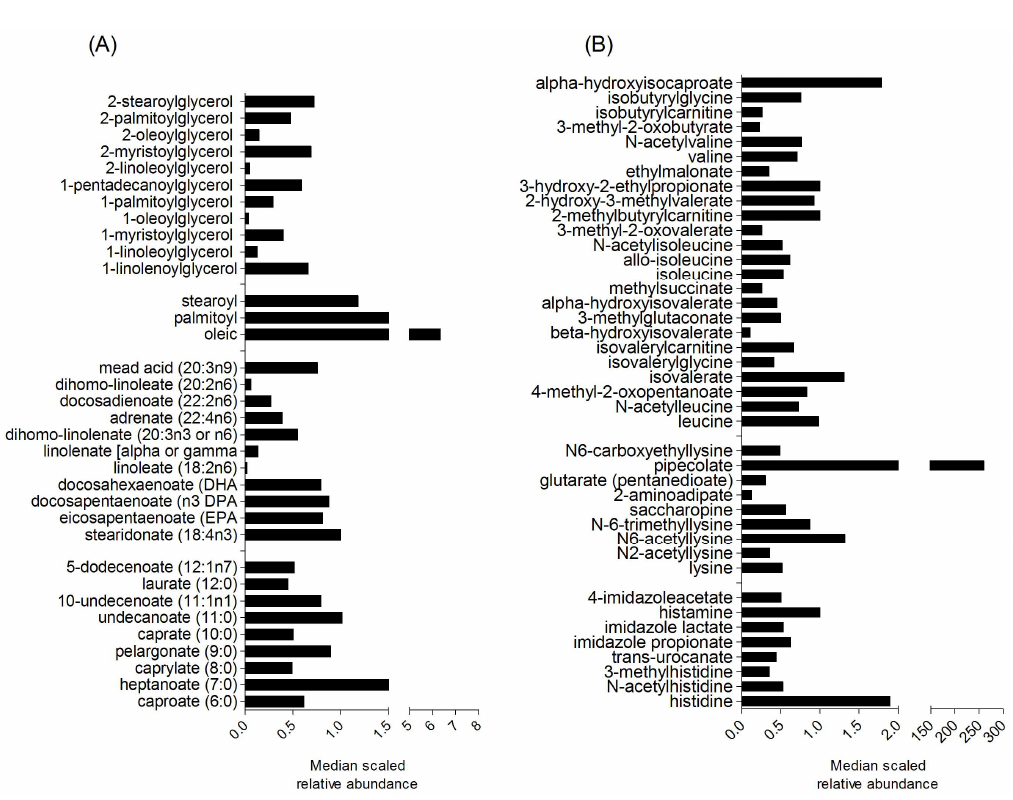
Figure 1. Median scaled relative abundances of selected navy bean metabolites classified as ( A ) lipids, and ( B ) amino acids. A complete list of the identified navy bean metabolites with the relative abundances can be found in Supplemental Table S1.